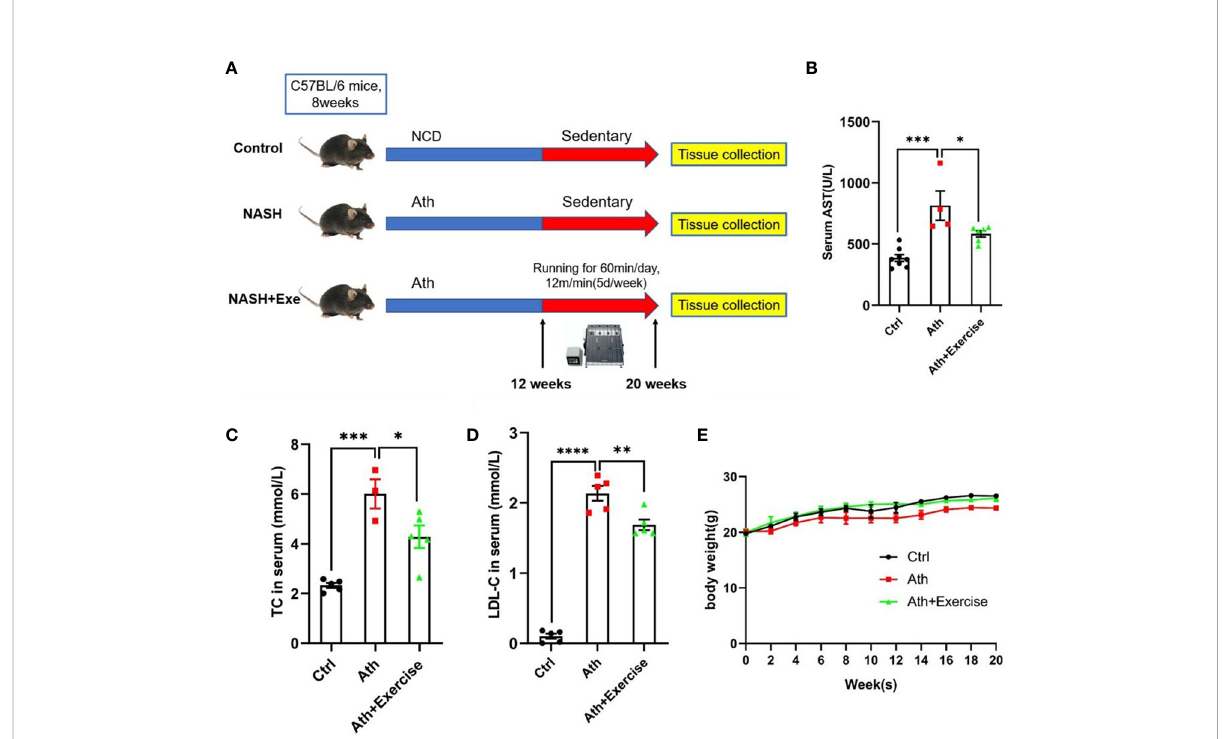
FIGURE 1 Body weight 、 liver enzymes and serum lipid metabolism index in mice. (A) Schematic diagram of mice running training. C57BL/6 male mice fed an Ath Diet or Normal Chow Diet (NCD) for 12 weeks and then started running training or sedentary training from 20 weeks of age for a period of 8 weeks. (B – D) Levels of serum AST (B) , serum TC (C) and LDL-C (D) after 8 weeks of running training. (E) Body weight time course. Data are depicted in mean ± SEM. *P<0.05; **P<0.01; ***P<0.001;